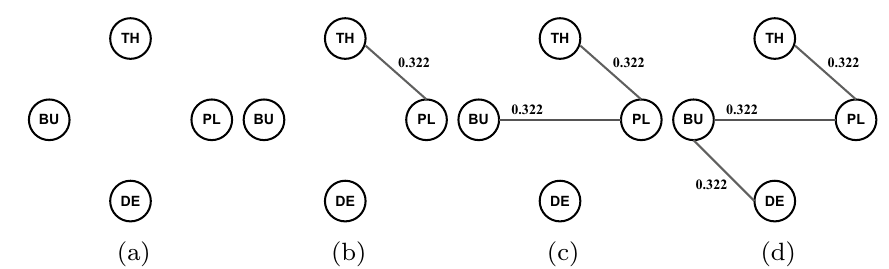
Fig. 5 Maximum spanning tree construction using Kruskal’s algorithms (a) Initial Tree with empty edges (b) Considering first maximum MI weight which is ( TH , PL ) (c) Considering second maximum MI weight which is ( PL , BU ) (d) Considering next maximum MI weight which is ( BU , DE